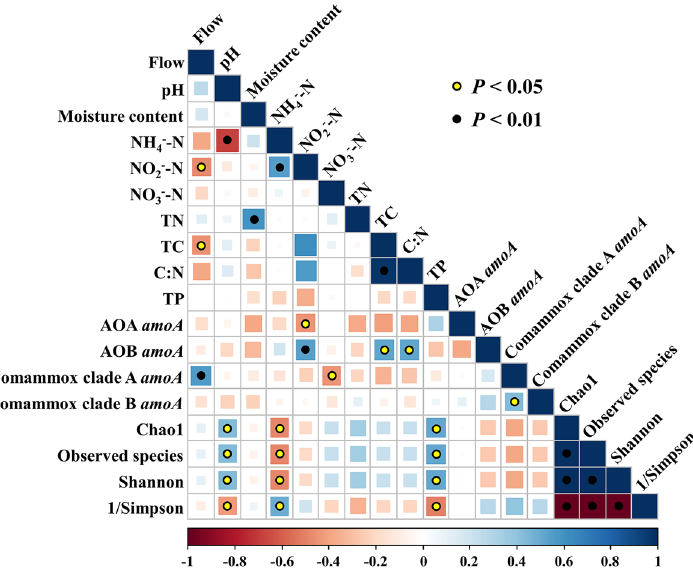
Figure 5. Heatmap exhibits the pairwise Spearman’s correlations among environmental parameters, amoA gene abundance of AOMs, and α-diversity indices of comammox Nitrospira community. Only the significant correlations ( P < 0.05) are labeled in circles. Different colors of scale bars (at the bottom) indicate different correlation coefficient